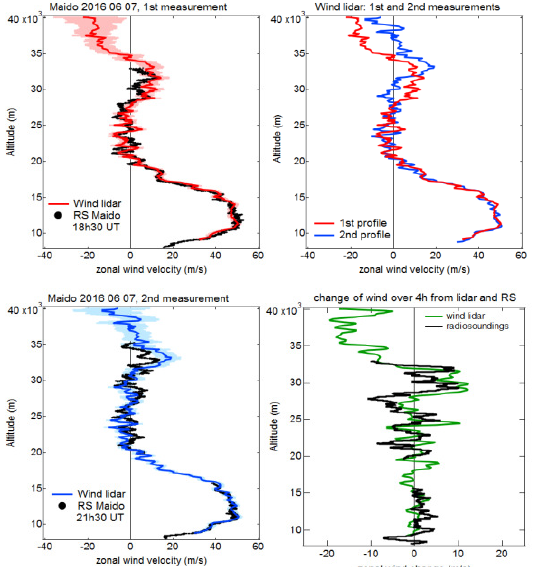
Figure 3. Verification of lidar temporally- resolved wind measurements using two radiosoundings: (top and bottom left) comparison of radiosonde and lidar wind profiles for the two consecutive soundings; (top right) comparison of two independent lidar profiles separated in time by 3 h; (bottom right) wind change over 3 h observed by lidar and